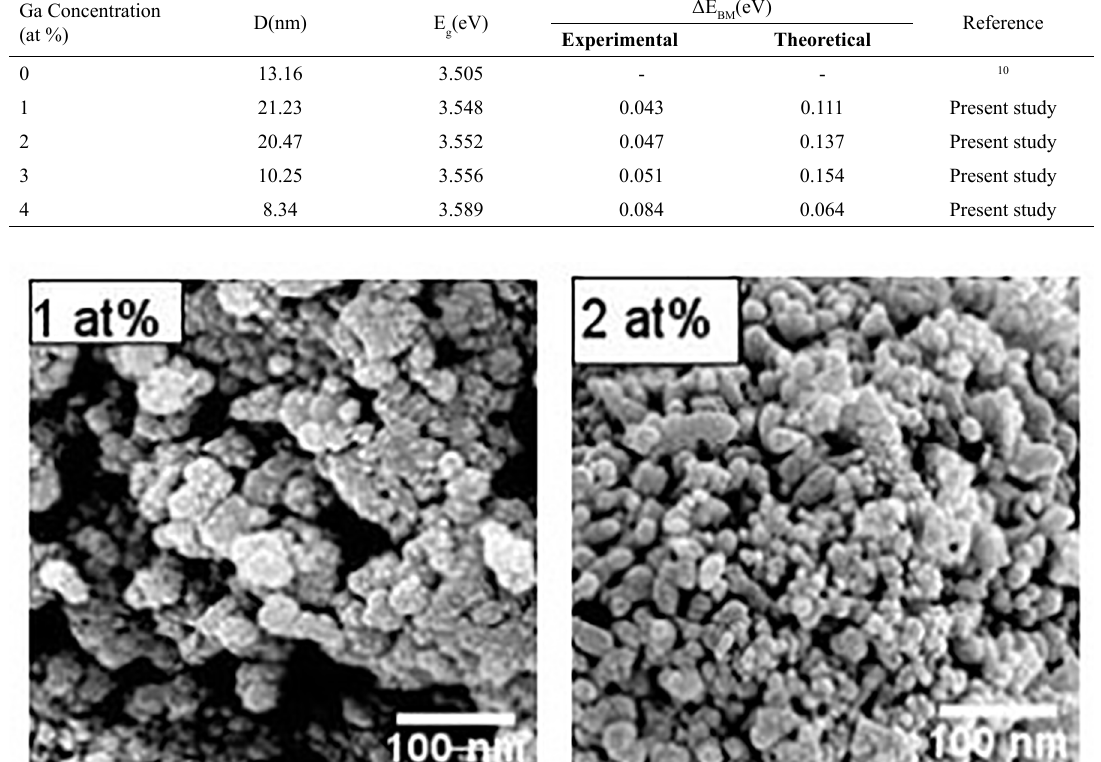
Ca O thin films. 0.85 0.15